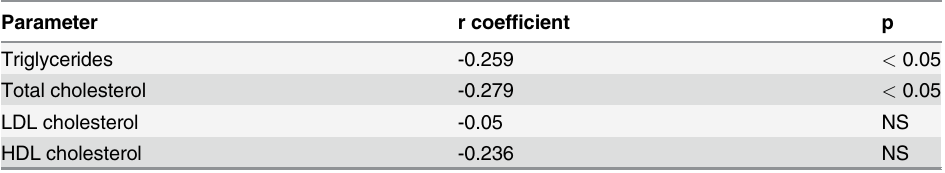
Table 2. Correlations of telomere length with lipid profile in patients with Cushing ’ s syndrome without statin treatment (n =